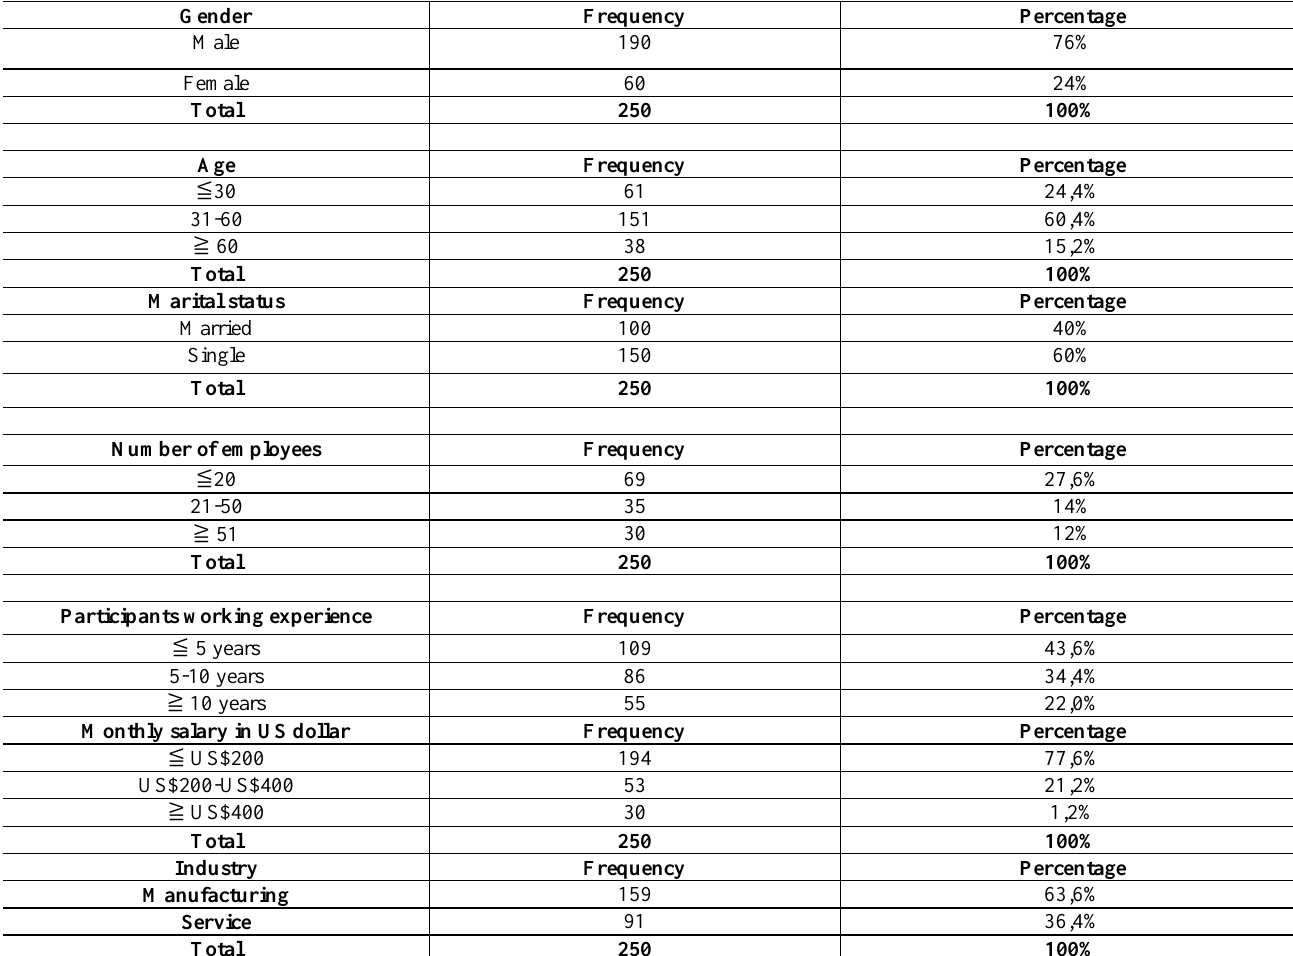
Table 1: Sample demographic